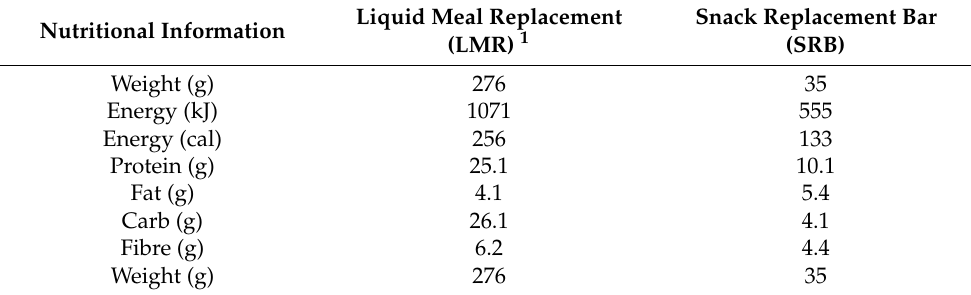
Table 1. Nutritional information for study products. Nutritional